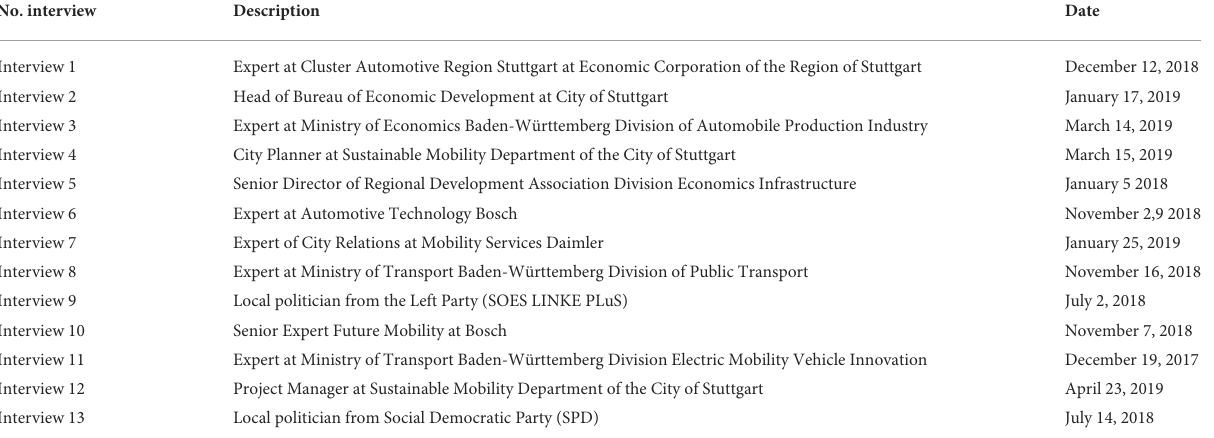
TABLE 1 List of interviews used for